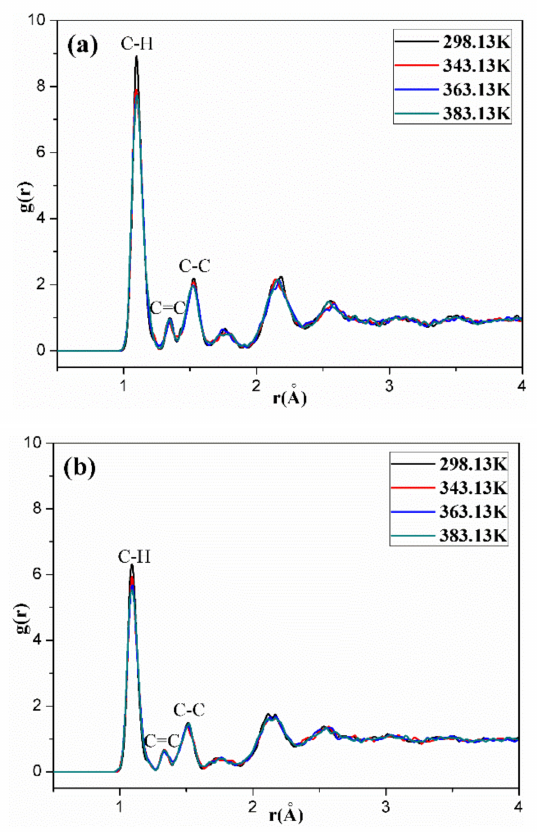
Figure 13. The radial distribution functions (RDFs) of carbon atoms (C–C) in the CO-NBR model in the uncompressed ( a ) and compressed ( b )